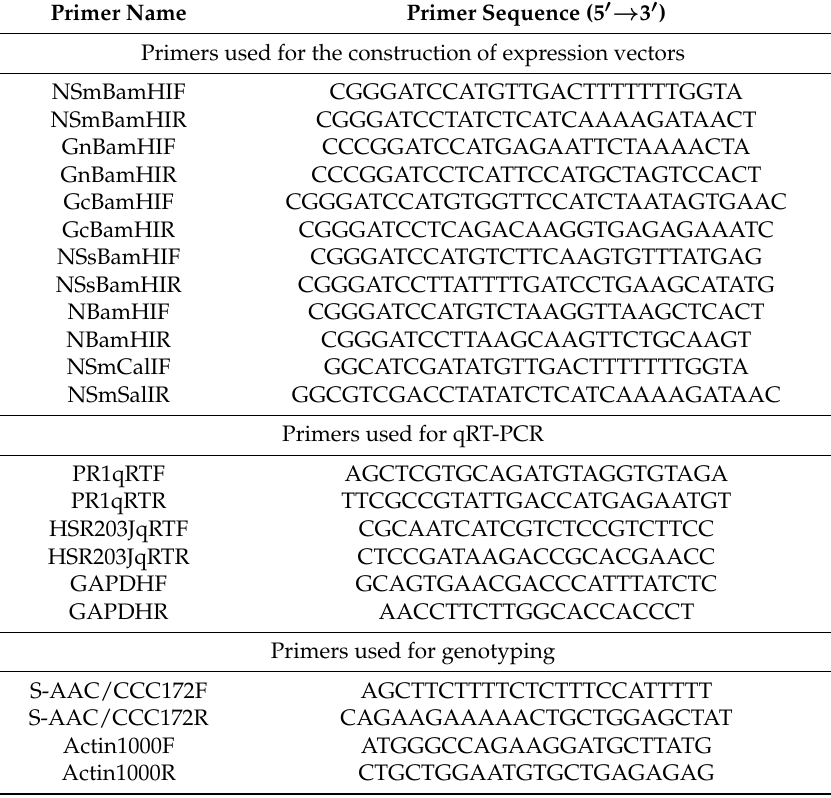
Table A1. Primers used in this